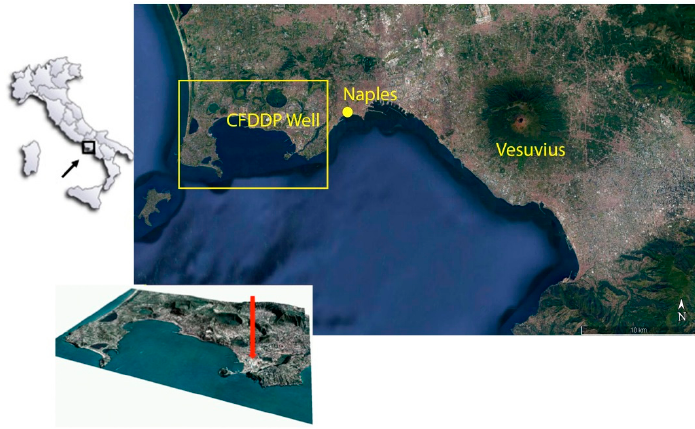
Figure 1. Map of the Neapolitan volcanic area in Southern Italy (Vesuvius, Campi Flegrei, Ischia island. The red square surrounds the Campi Flegrei caldera, containing part of large city of Naples. The yellow circle (and the red arrow in the small perspective view of the caldera) indicate the site of the Campi Flegrei Deep Drilling